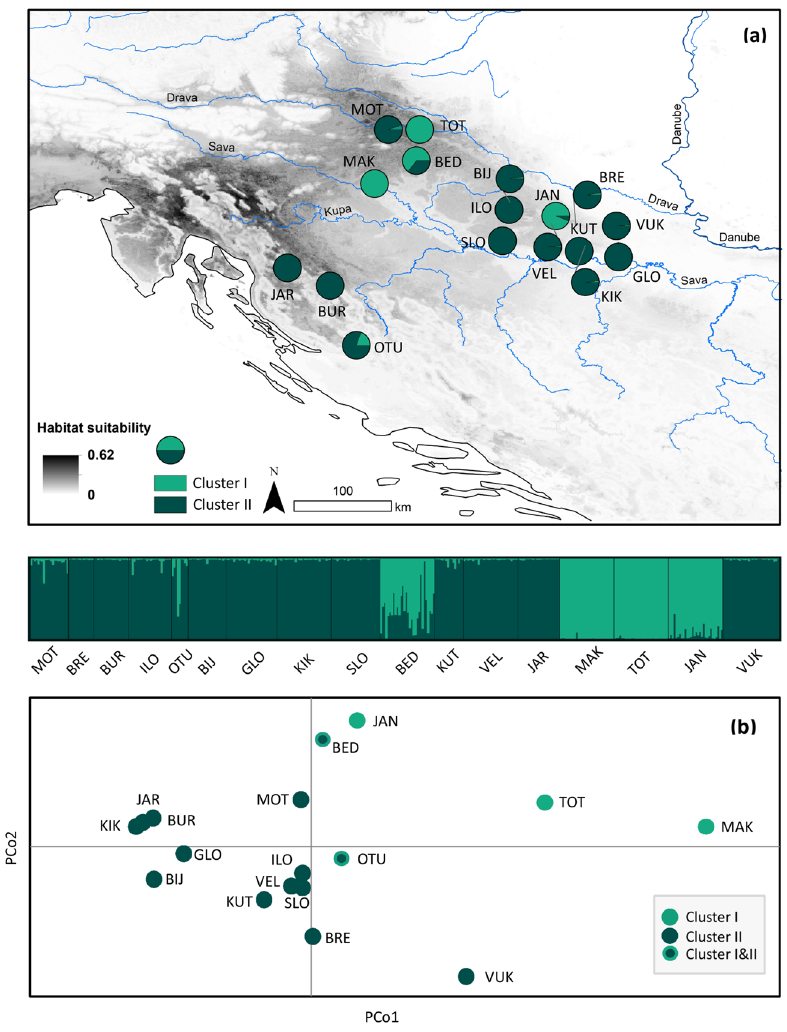
Figure 2. Genetic structure of the 17 studied Astacus astacus populations (see Table 1 for abbreviation) based on 15 microsatellites. (a) Genetic clustering inferred by STRU CTU RE with the suggested K = 2 clusters. (b) Plots of the first two axes of a principal coordinates analysis (PCoA) based on Nei’ D A genetic distances. Each dot represents one population with colours depicting genetic cluster identified in STRU CTU RE. Grey shading in the map indicates projected future habitat suitability for A. astacus under RCP 8.5 scenario in 2070. Map was produced in ArcGIS 10.3 program package by authors of this